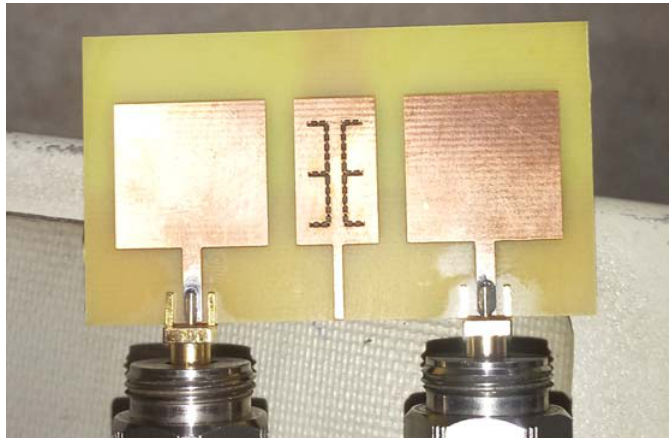
Figure 9. Current density of 2 1 × microstrip patch antenna array with slotted MTM-DS.